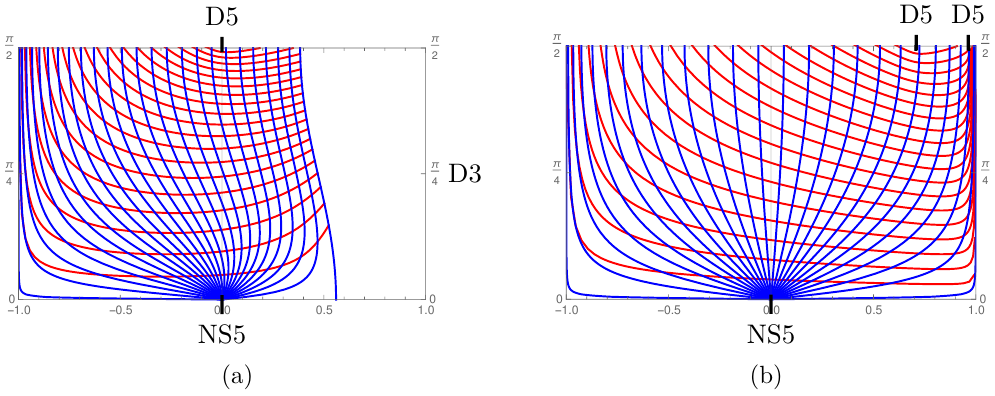
Figure 8. Left: ‘Wilson loop coordinates’ on (part of) Σ for the BCFT dual (2.8) with N 5 = 4 K . The D5 0 -branes extend along the blue curves along which h D cap-off points of the D5 0 branes. Compare the region carved out by the blue curves to figure 3. Right: corresponding Wilson loop coordinates on Σ for 3d dual (3.9) with N 5 = 4 K . The coordinates now cover Σ